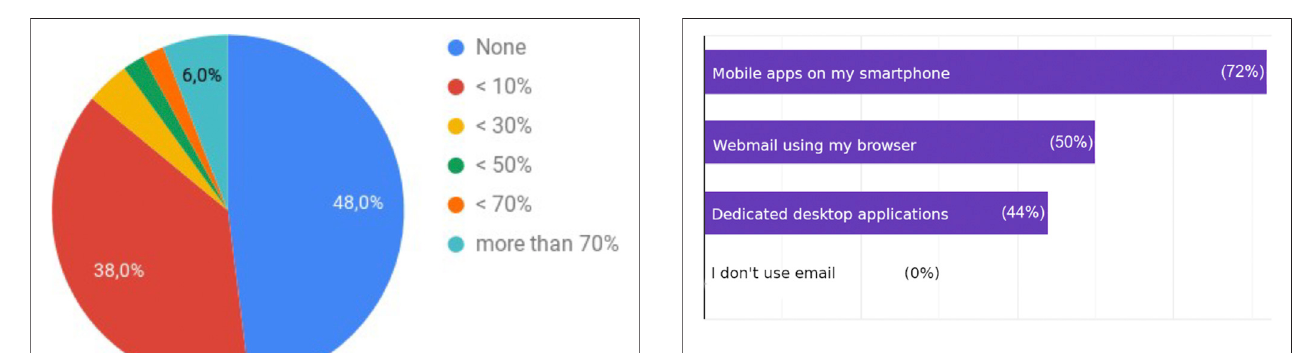
FIGURE2| Answers tothequestion: Whichmail softwaredoyou useto access your e-mails